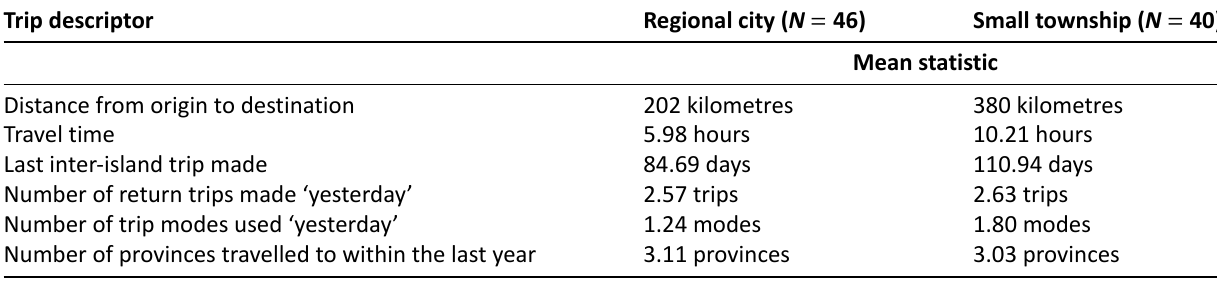
Table 1. Mean statistics for regional cities vs. small townships. Trip